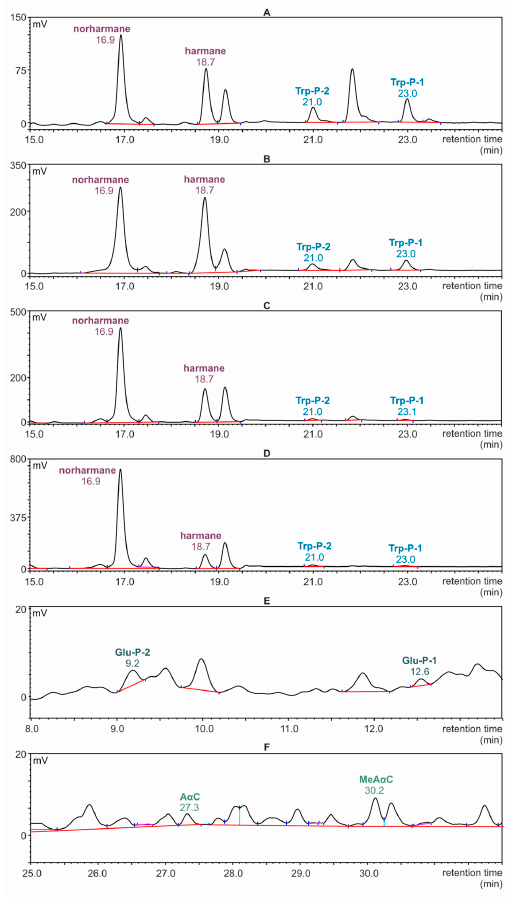
Figure 3. HPLC-FLD chromatograms of fractions separated from roasted meat samples. ( A – D ): sections of chromatograms with a selected retention time range (15–25 min) at which β - and γ - carbolines were determined. ( A ): Meat without additives; ( B ): meat with prunes; ( C ): meat with apricots; ( D ): meat with cranberries; ( E , F ): sections of chromatograms recorded for meat without additives; ( E ): retention time range at which δ -carbolines were determined (8–13.5 min); ( F ): retention time range at which α -carbolines were determined (25–32